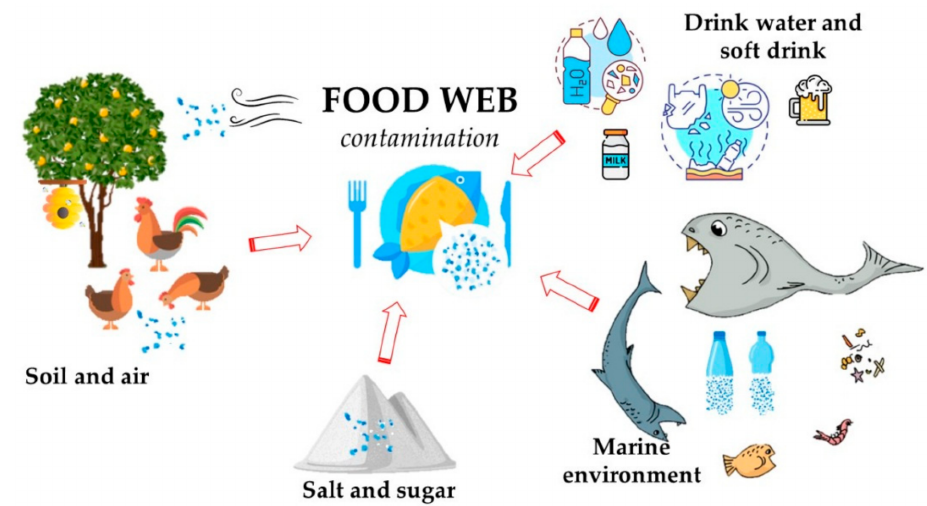
Figure 1. Scheme of food web contamination due to MP